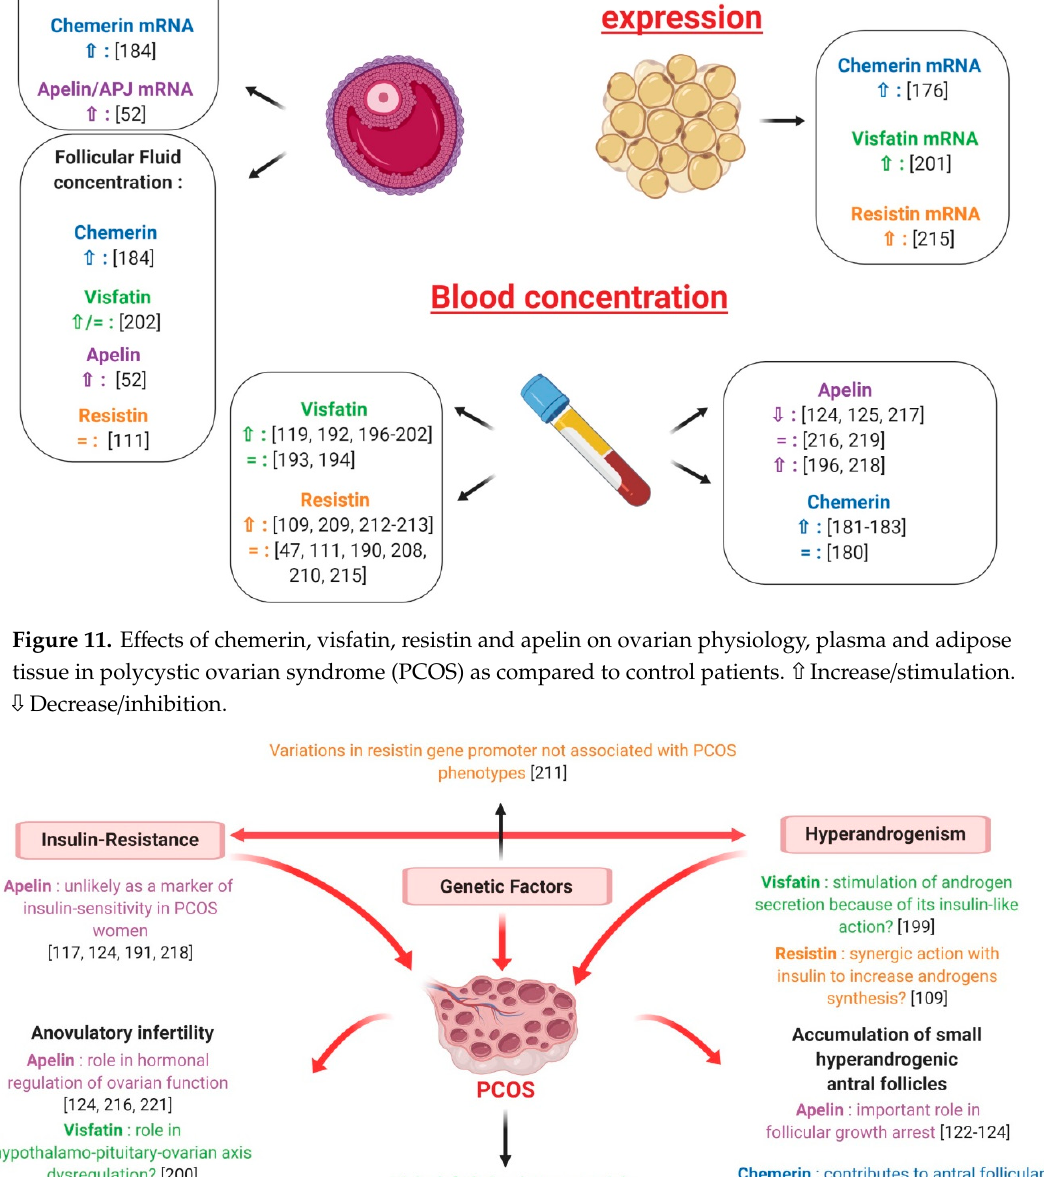
Figure 12. Description of PCOS syndrome and possible involvement of chemerin, visfatin, resistin and apelin in this syndrome.